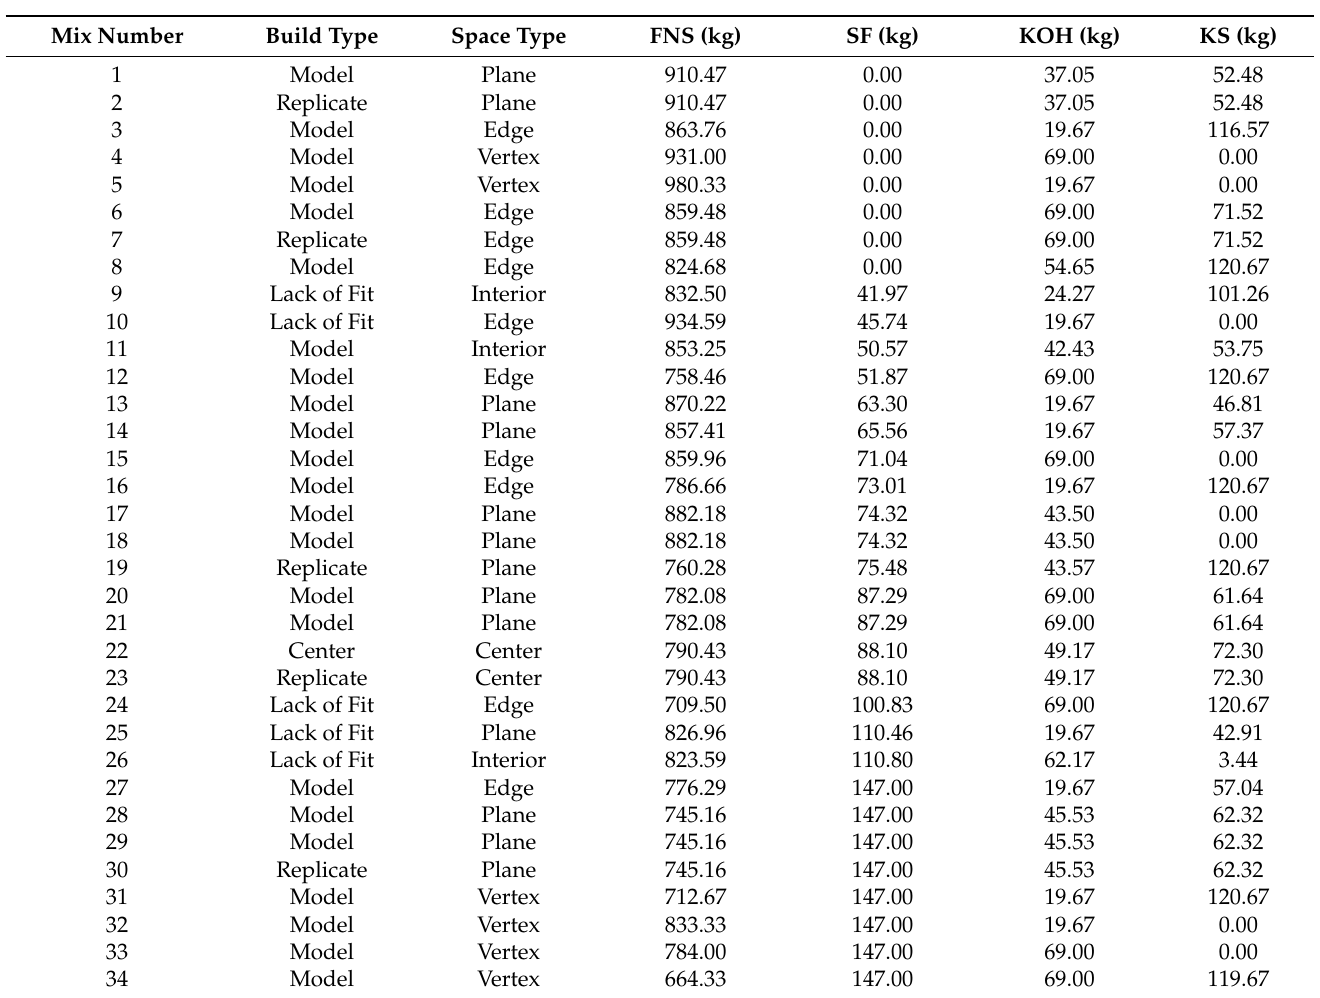
Table 3. Ferronickel slag-based alkali-activated paste compositions for 1 m 3 (176 kg of water was added to each